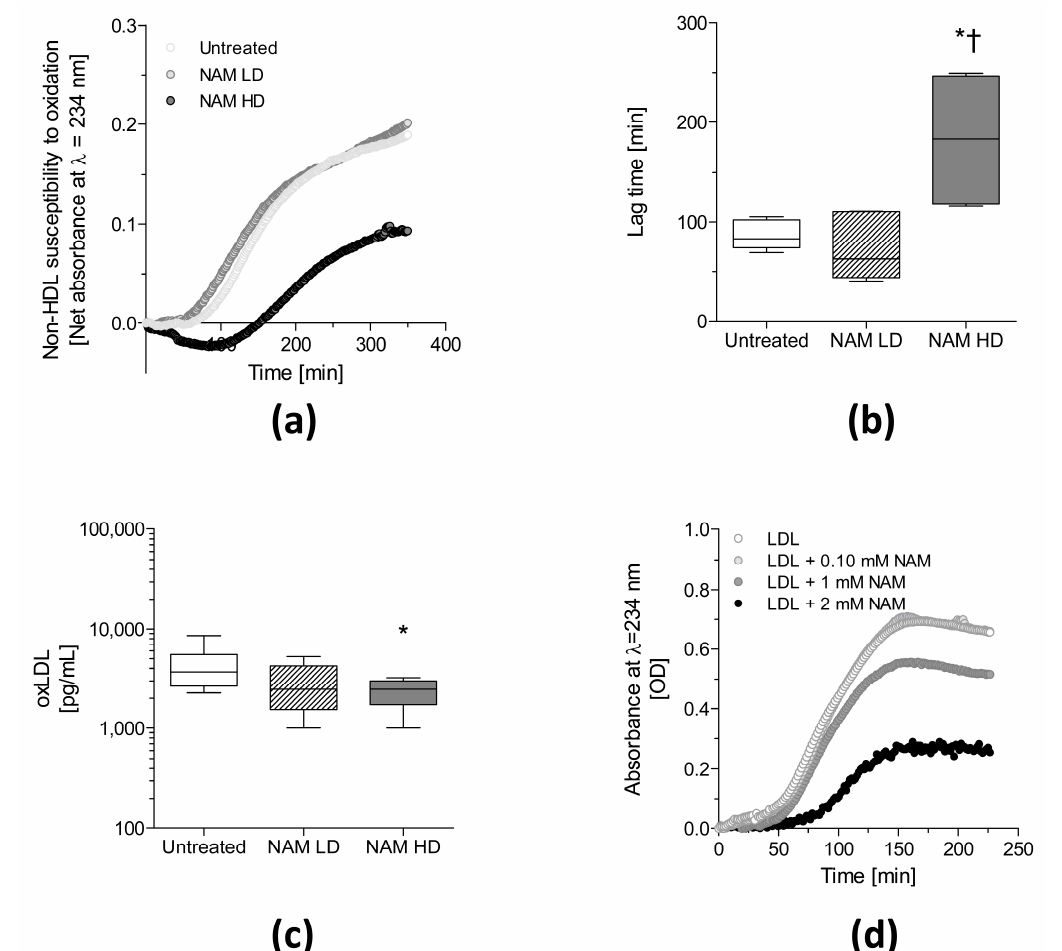
Figure 2. Antioxidant effects of NAM on ApoE-deficient mice. Two-month-old male ApoE-deficient mice were challenged with a Western diet and NAM for 1 month. ( a ) Representative diene formation curves of non-HDL particles. ( b ) Median diene formation lag time calculated from the oxidation curves (n = 3–4 plasma pools/group). ( c ) Serum oxLDL concentration (n = 8 per group). ( d ) Oxidation curves of human LDL incubated at NAM concentration 0.10 mM and 1.0 mM. This experiment was replicated twice with similar outcomes. Oxidation kinetics were carried using plasma lipoproteins isolated by sequential ultracentrifugation from pools of 2–3 mouse plasmas of each experimental group, panels ( a , b ), or pooled human plasma, panel ( d ), as appropriate. In panels ( b , c ), data are expressed as medians (interquartile ranges). Statistically significant differences among groups for each variable were determined using a nonparametric a Kruskal–Wallis test followed by Dunn’s posttest. Differences were considered significant when p < 0.05. Specifically, * p < 0.05 vs. Untreated group or † p < 0.05 vs. NAM LD-treated mice. Abbreviations used: NAM LD, low-dose, NAM-treated mice; NAM HD, high-dose, NAM-treated mice; OD, optical density.